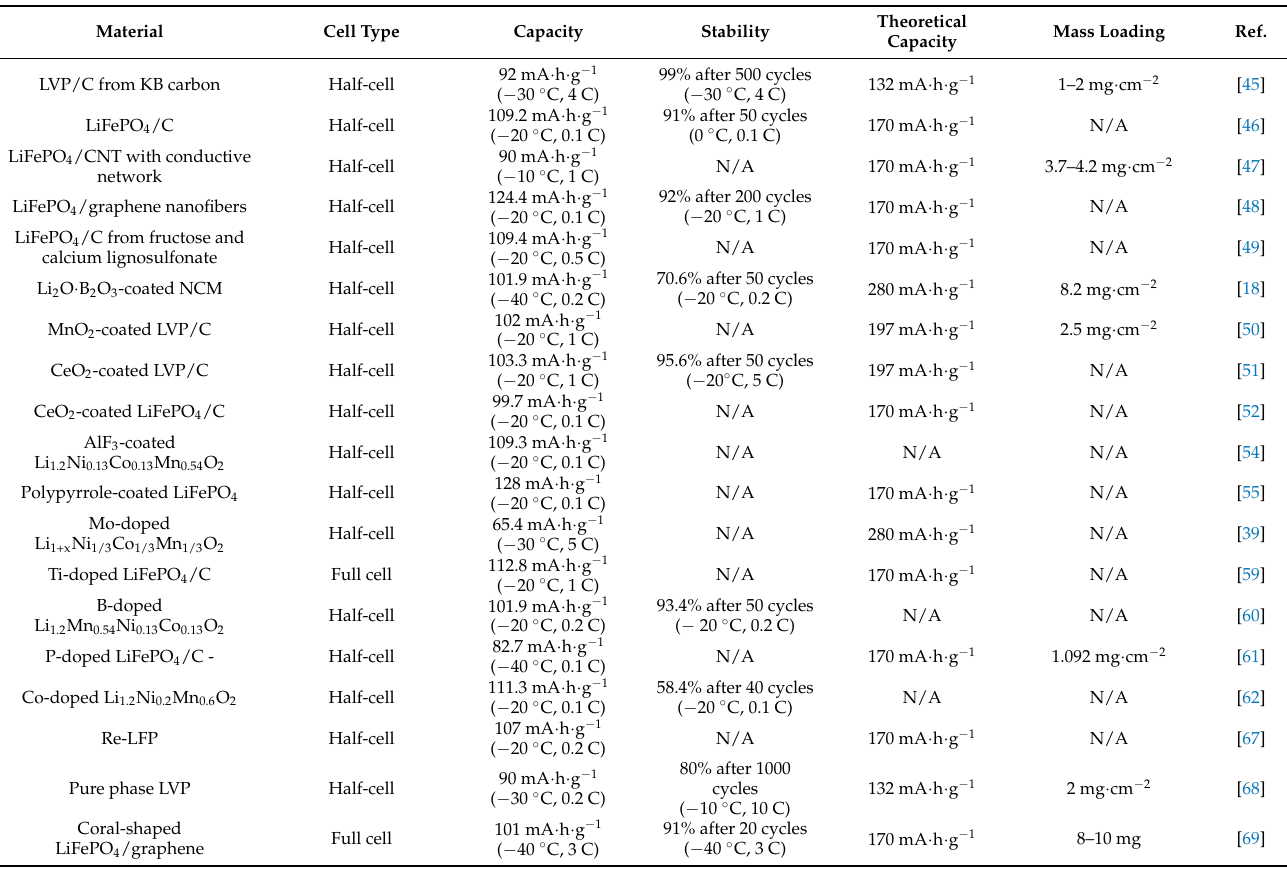
Table 1. Summary of the low-temperature electrochemical properties of different notable